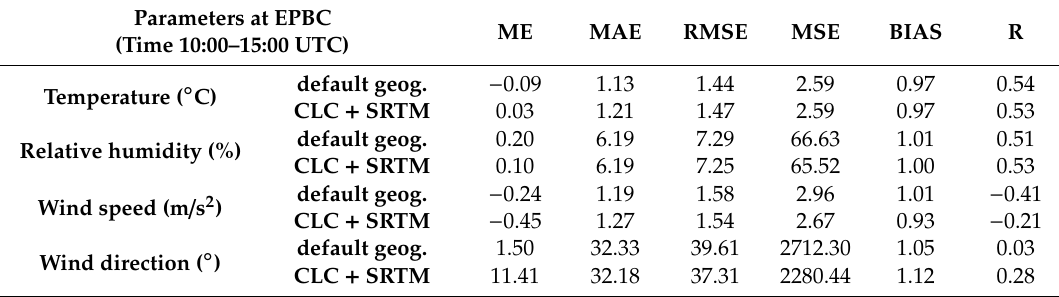
Table 6. Average statistical evaluation of the simulations for EPBC: ME, MAE, RMSE, MSE, BIAS, and R statistics. 382